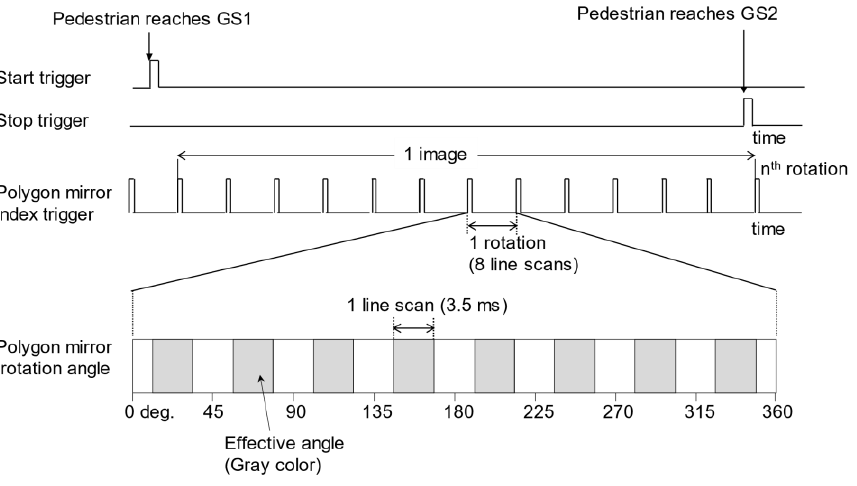
Figure 9. Timing chart for the acquisition of an image.